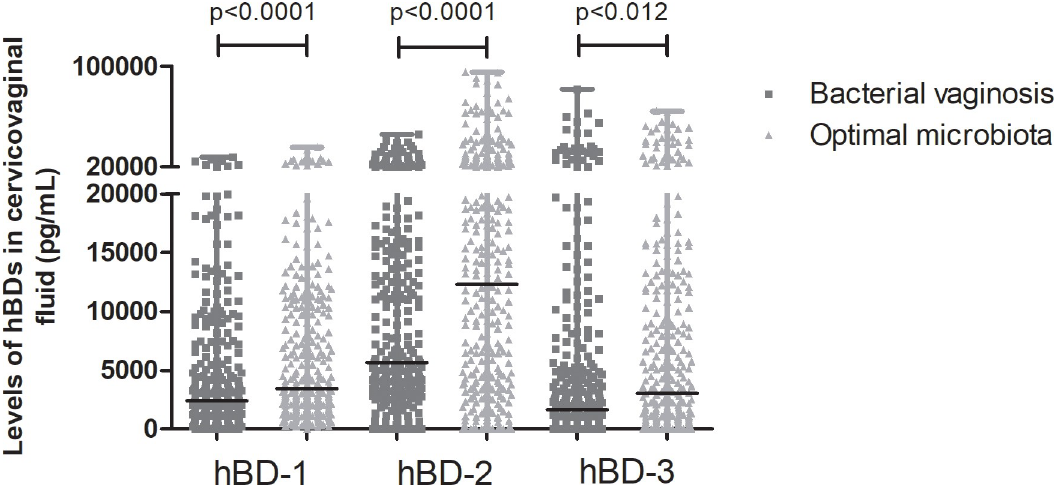
Fig 1. Levels of human beta defensin (hBD)-1, 2 and 3 in cervicovaginal fluid samples of women with bacterial vaginosis (n = 317) compared to those with optimal microbiota (n = 317). Horizontal bars represent median values. Mann-Whitney U test, p <